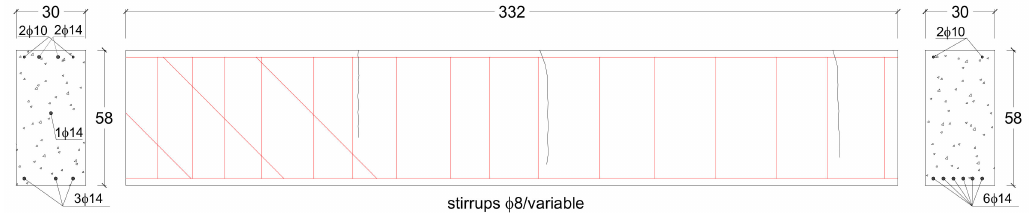
Figure 10. Global dimensions and steel reinforcement of the